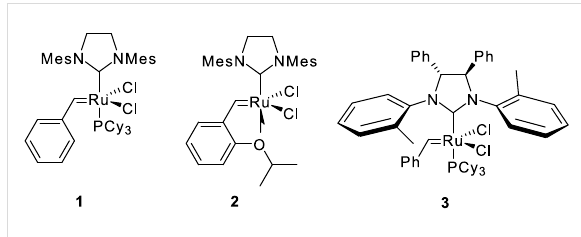
Figure 1: Ruthenium based precatalysts used in this study.